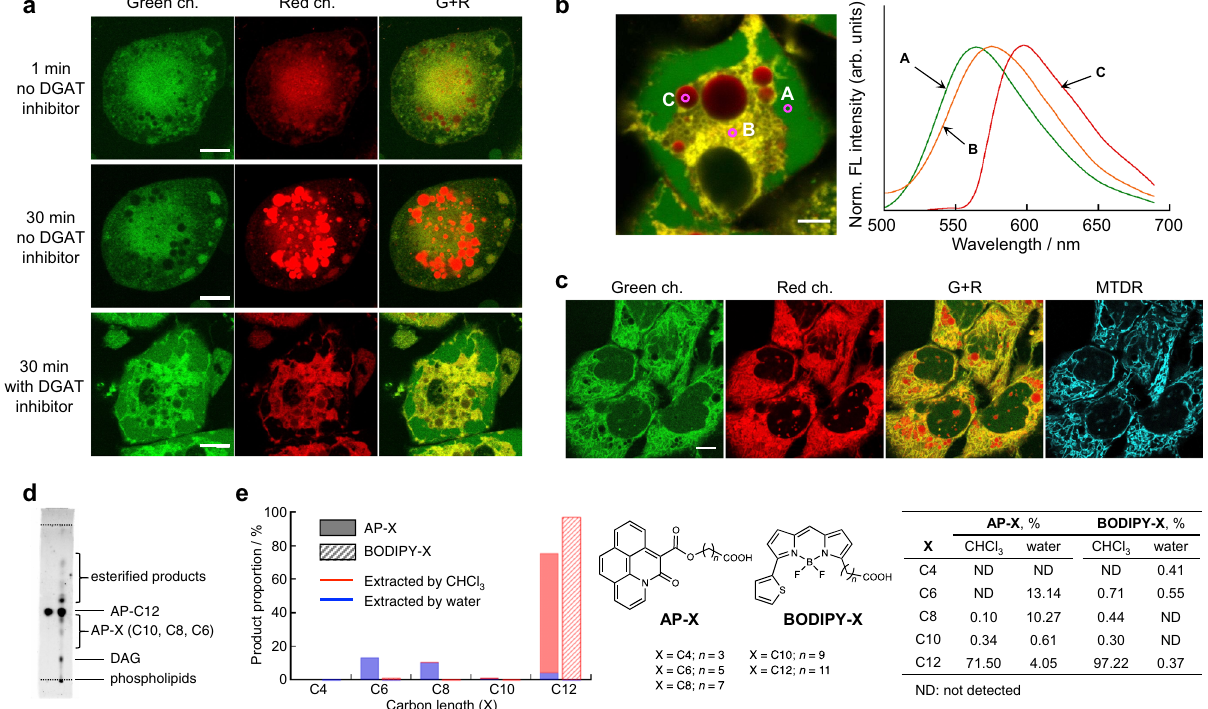
Fig. 2 Distribution of AP-C12 metabolites in live cells. a Confocal images of 3T3-adipocytes recorded in the green (left) and red (center) channels upon treatment with AP-C12. The merged images of the two channels are shown at the right. The images were captured 1 min (top) and 30 min (middle) after the addition of AP-C12. The images at the bottom were recorded after treatment with 2-bromooctanoate (1.2 mM) for 30 min, followed by incubation with AP-C12 for 30 min. Scale bar: 20 µ m. b Unmixed image of 3T3-adipocytes (left) using the reference spectra of selected pixels in A, B, and C. The cells were treated with 2-bromooctanoate for 30 min prior to incubation with AP-C12. The emission spectra for the corresponding areas are shown at right. Scale bar: 5 µ m. c Images of HepG2 cells incubated with AP-C12 and subsequently labeled with MitoTracker Deep Red FM (MTDR: λ ex = 635 nm and λ = 660 – 710 nm). Scale bar: 10 µ m. d TLC image of AP-C12 (left) and its metabolites extracted by chloroform from HepG2 cells (right). The cells were em incubated with 5 μ M of AP-C12 in HEPES-buffered HBSS + for 6 h. The mobile phase is a mixture of chloroform/methanol, 9:1 (vol/vol). e Relative proportions (%) of the β -oxidation products (AP-X and BODIPY-X; X = C4, C6, C8, and C10) for AP-C12 ( fi lled bar) and BODIPY 558/568-C12 (hatched bar). The products extracted with water and CHCl 3 are shown in blue and red, respectively. The results represent the average of two experiments. Source data for this fi gure are provided as a Source Data fi